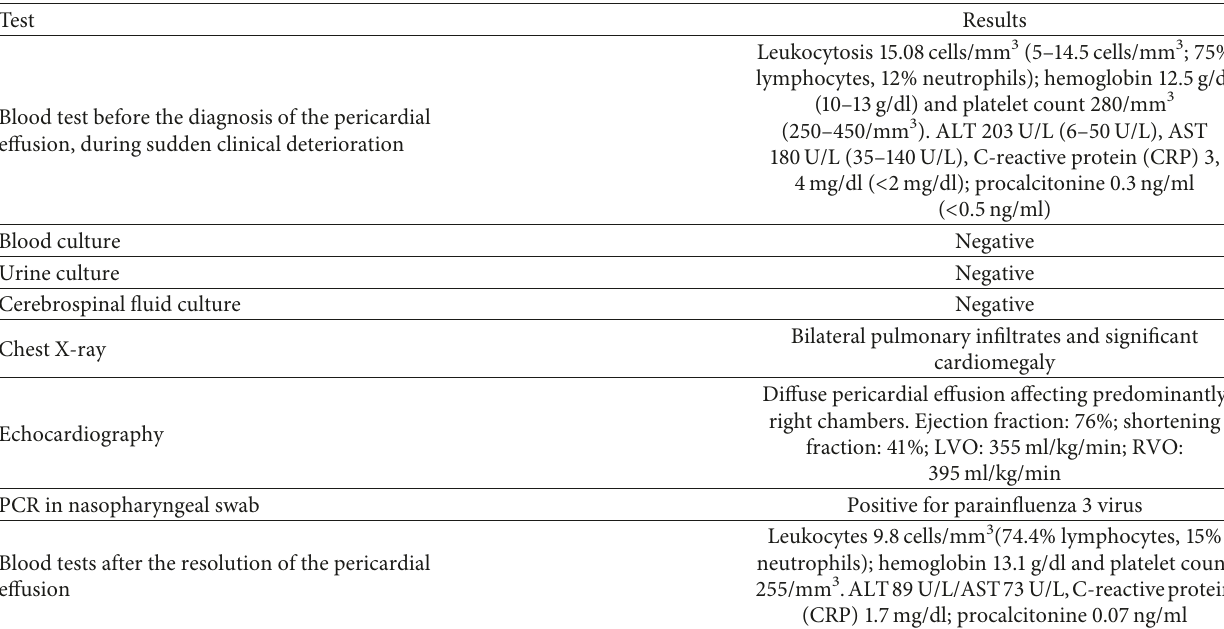
Table 1: Diagnostic tests